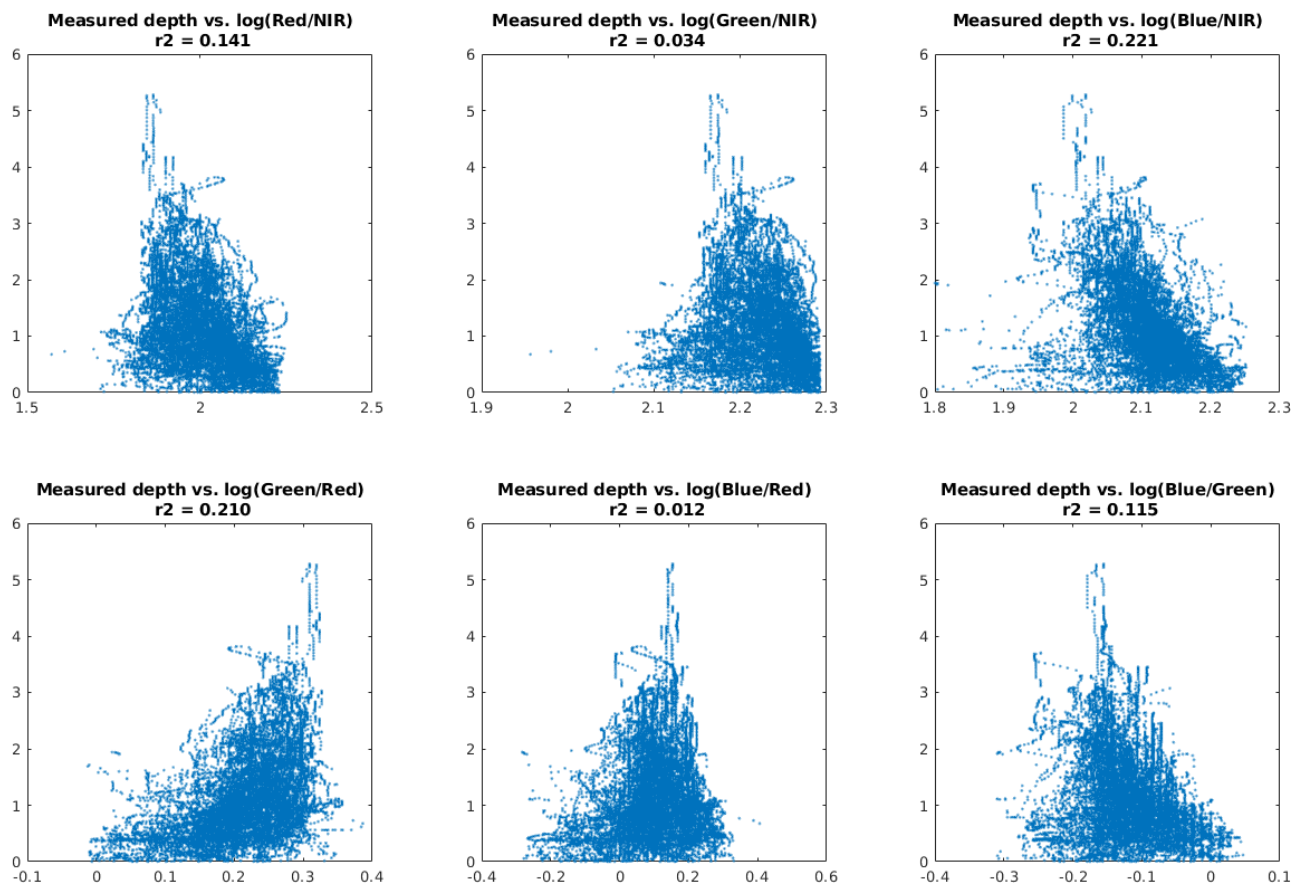
Figure 14. Correlation between measured depth and the log of the six different spectral ratios that can be defined with four-band imagery.